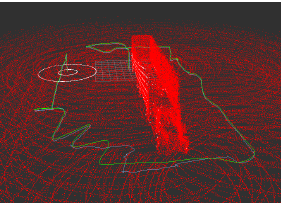
Figure 28. Pose estimation by ICP-NL. Three-dimensional map (red), ground truth path (green), ICP-NL path (blue).